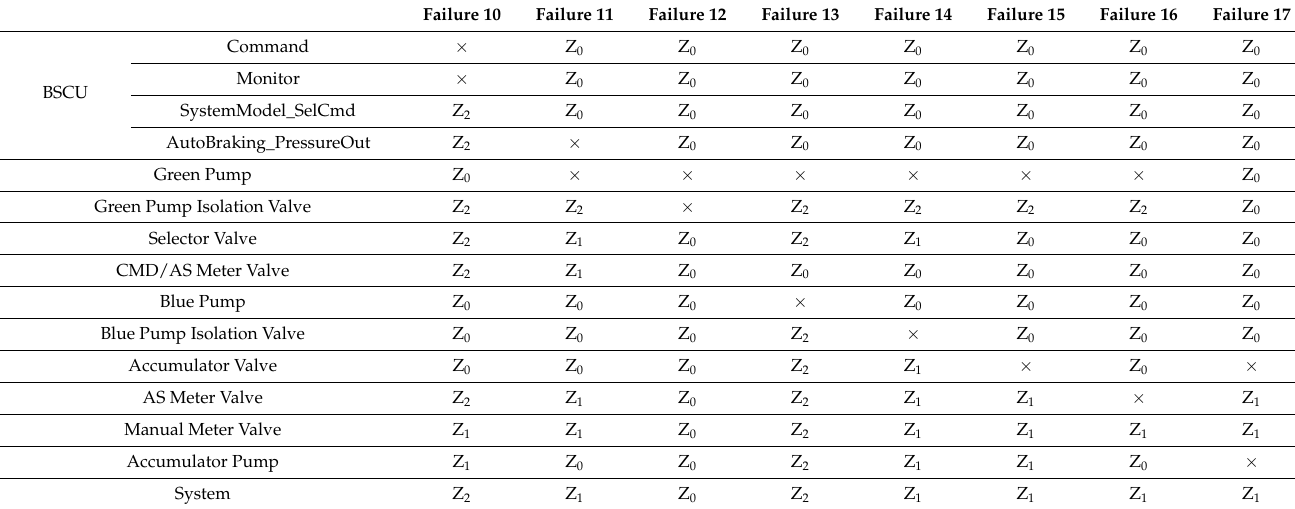
Table 6. Component States under double fault simulation.